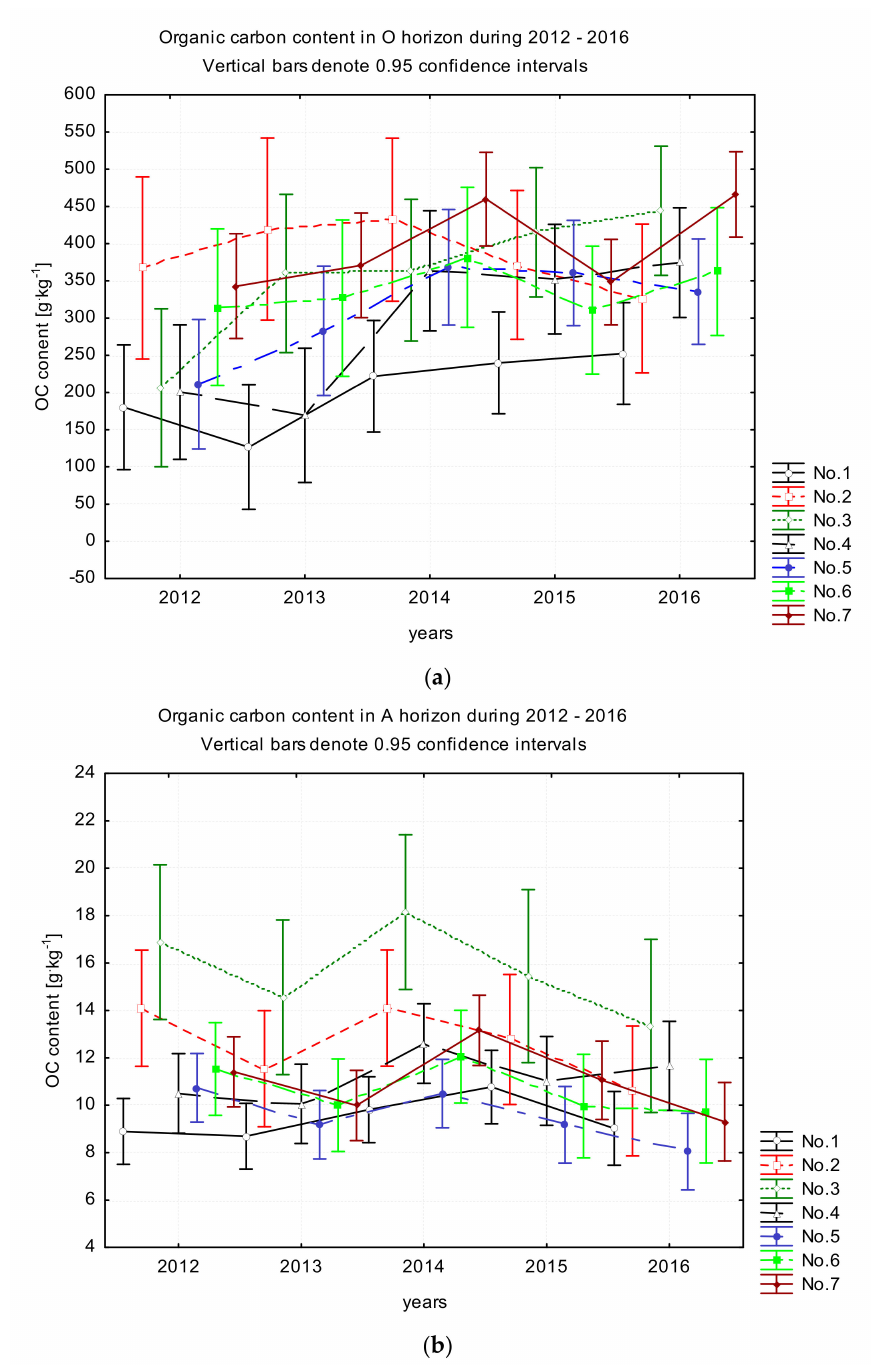
Figure 5. Annual average organic carbon content in ( a ) O and ( b ) A horizons. Although previous statistical analyses showed the dependence of dehydrogenase activity on the age of the stand, soil moisture and carbon content at the O horizon, the research plots analyzed did not differ from each other in terms of the activity of